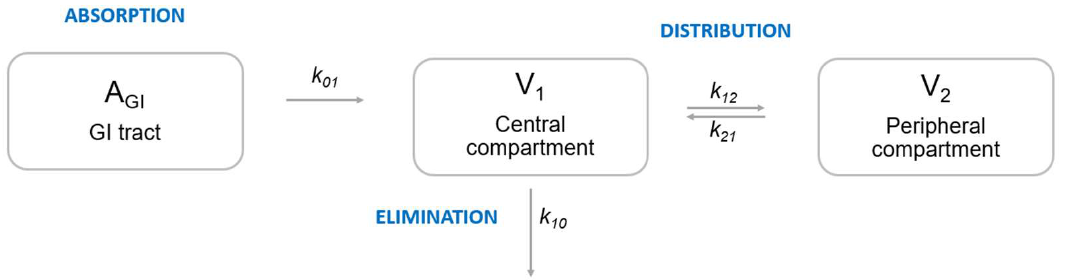
Figure 2. Illustration of a two-compartment pharmacokinetic model for a fictive drug. A GI , amount of drug in the gastrointestinal tract; k 01 , absorption rate constant; k 10 , elimination rate constant; k 12 , rate constant describing distribution from central to peripheral compartment; k 21 , rate constant describing distribution from peripheral to central compartment; V 1 , volume of central compartment (e.g., blood); V 2 , volume of peripheral compartment (e.g., brain tissue). Drug clearance is expressed as k 10 × V 1 .